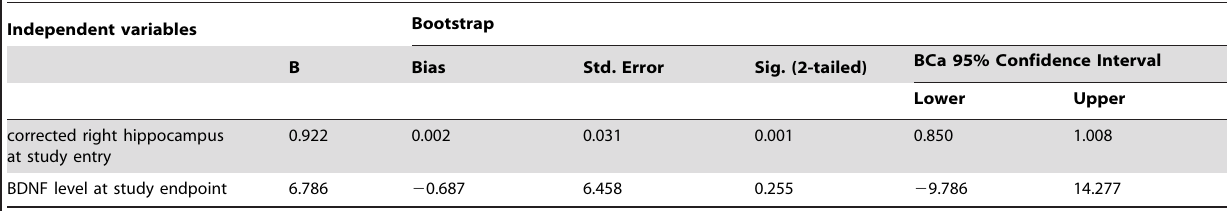
Table 7. Bootstrap for